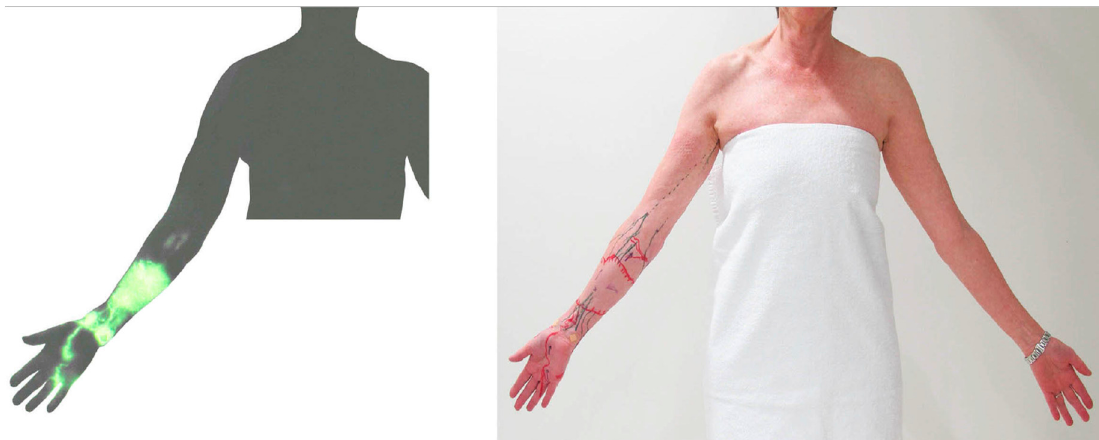
Figure 8. Indocyanine green (ICG) lymphography image (left) and tracing photo (right) in a patient with breast cancer-related lymphoedema. The ICG signal disappeared at the elbow and reappeared in the axilla. This suggests a connection between superficial and deep lymphatics.